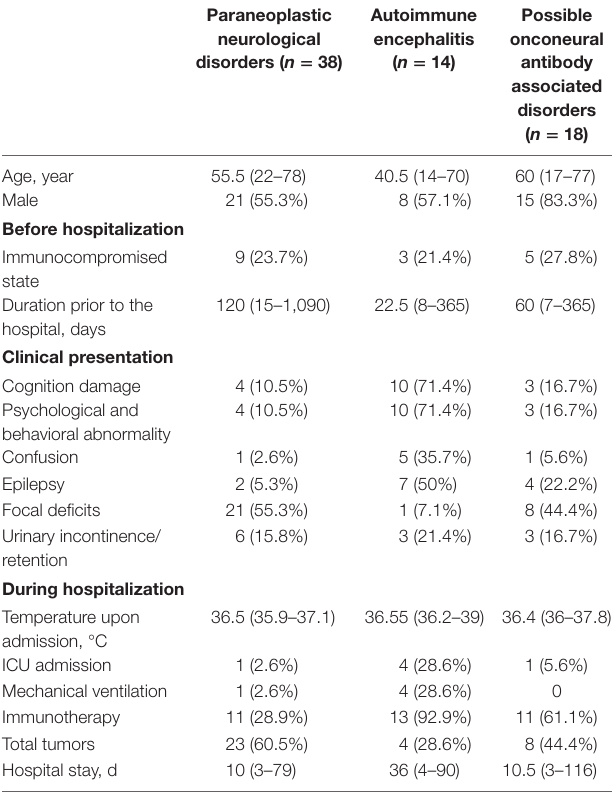
Table 2 | Demographics, clinical presentation, and